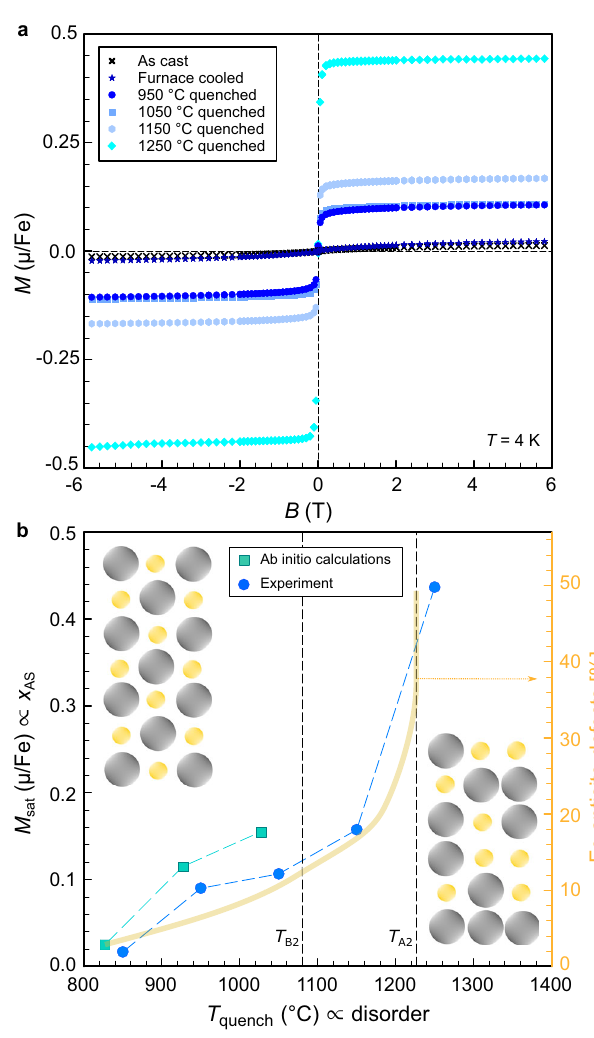
Fig. 3 Quanti fi cation of disorder by low-temperature magnetisation. a Field-dependent magnetisation of Fe 2 VAl at T = 4 K for different quenching temperatures. b Experimental and calculated saturation magnetisation versus quenching temperature. The insets show a sketch of atomic disorder, increasing with T quench . Right scale shows the calculated concentration of Fe antisite defects (yellow curve) from Fig. 1b, rescaled to the experimental transition temperatures T B2 , T A2 22